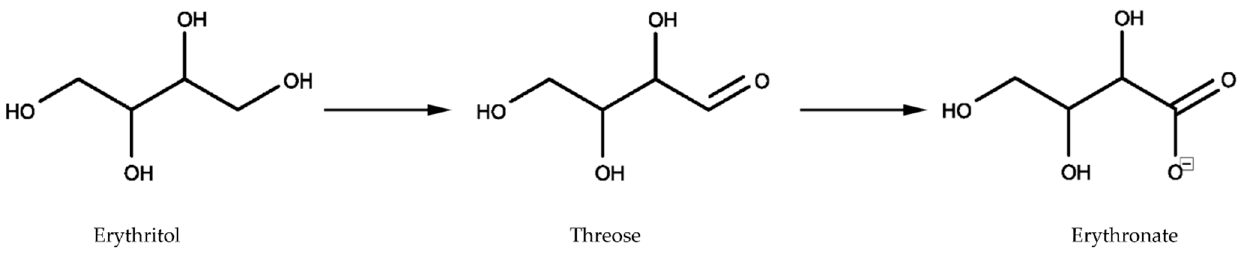
Figure 5. Oxidation reactions of erythritol into threose and